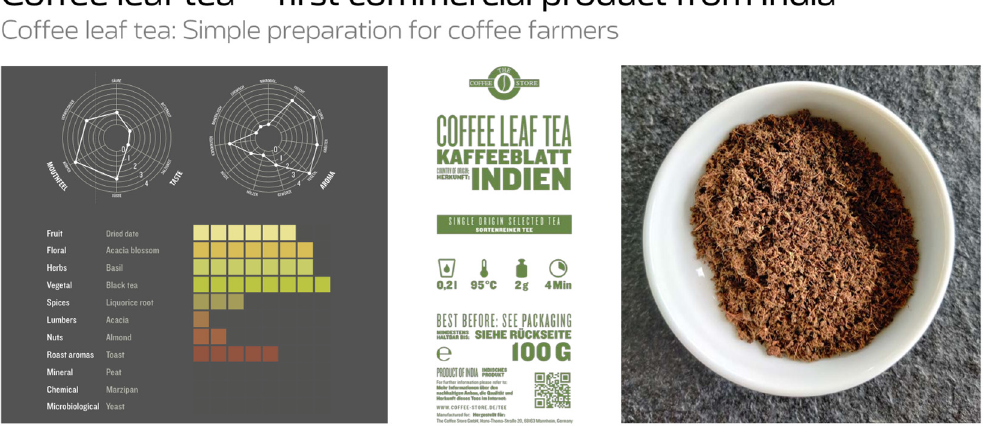
Figure 4. Representation of a commercial coffee leaf tea from India.